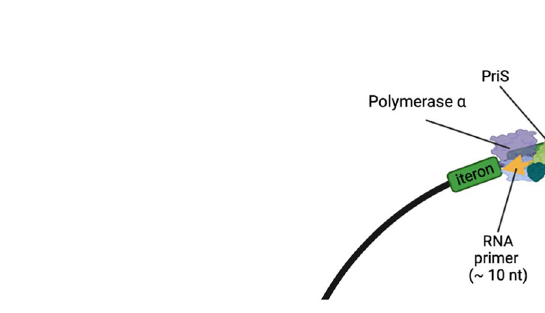
FIGURE 2 A model for the DNA Primase complex, consisting of PriL, PriS, and DNA polymerase a , producing an RNA primer near the hairpin loop of the ss- DNA of geminiviruses. DNA polymerase a consists of a catalytic subunit (p180) and an accessory subunit (p70). We hypothesize that in the resistant melon one or more mutations in PriL hamper the production or extension of the primer on the viral DNA, but still supporting the primer production in DNA replication forks of the host plant.